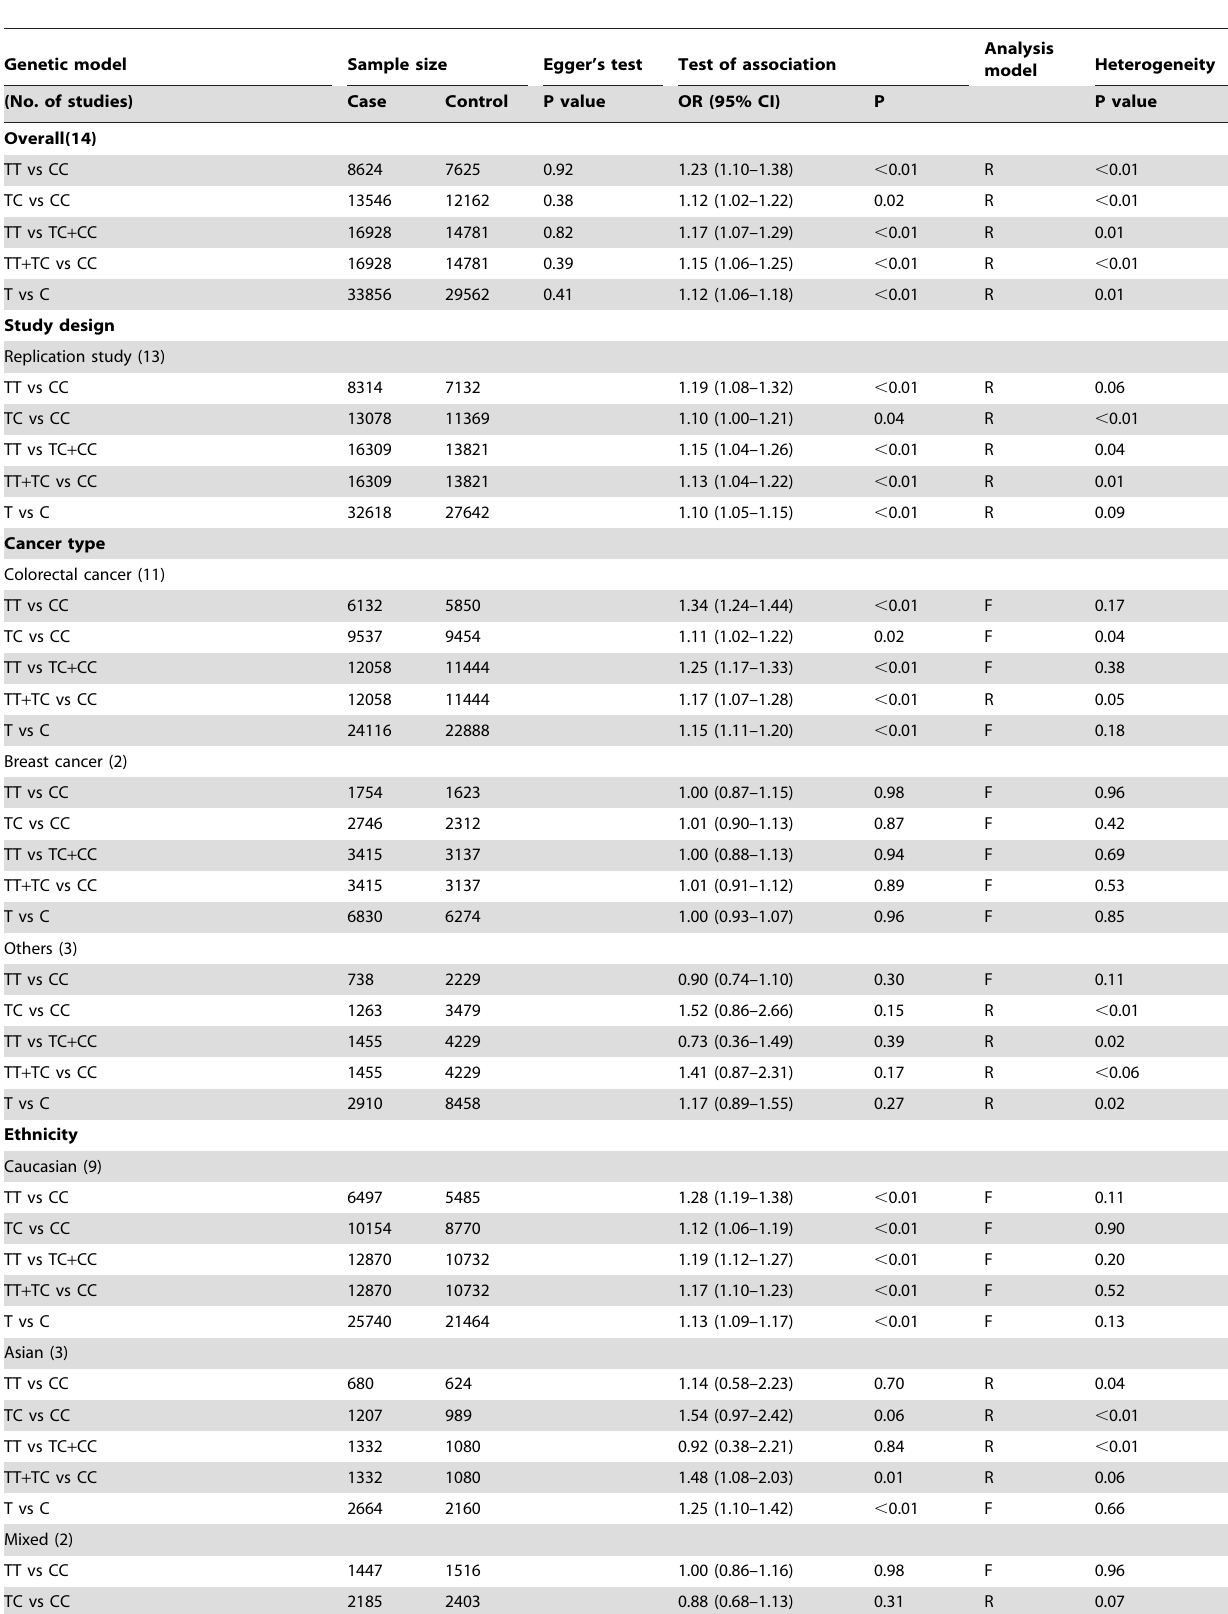
Table 2. Meta-Analysis of SMAD7 rs12953717 Polymorphism and